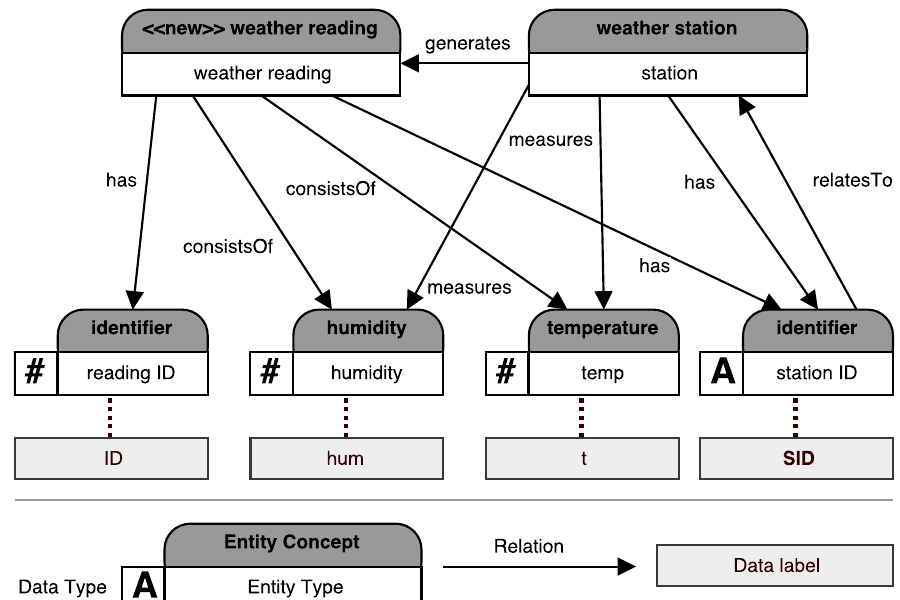
Figure 7. Detailed view of a data source and its connected semantic model giving a semantic description of the information contained in the data set. The semantic model consists of Entity Types only, which are extended by Entity Concepts contained in the Knowledge Graph. The data type, which can be seen in Entity Types that model a data attribute, defines how the data in this attribute is to be interpreted (String, Number, Boolean, Binary,